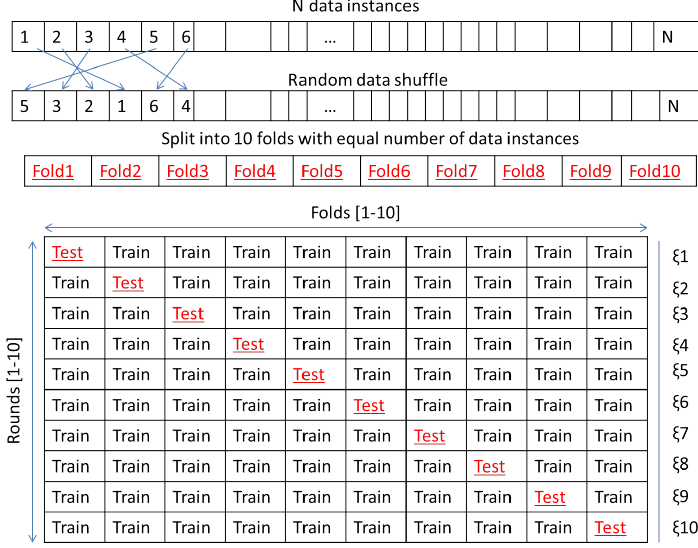
Figure 7. Ten-fold cross validation method for classification of N data inputs (N = 531 in this